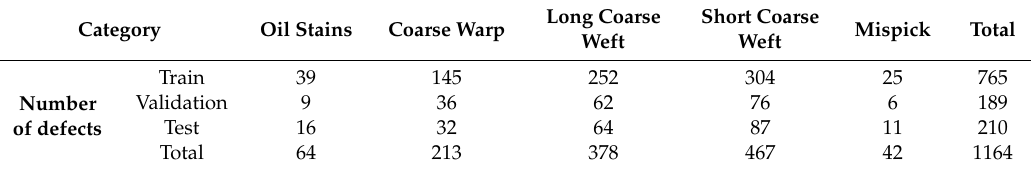
Figure 5. Samples of the defects in the plain fabric images. ( a ) oil stain, ( b ) long coarse weft, ( c ) long coarse warp, ( d ) long coarse weft, ( e ) short coarse weft, and ( f ) mispick. Table 1. The number of each category defect of the plain fabric